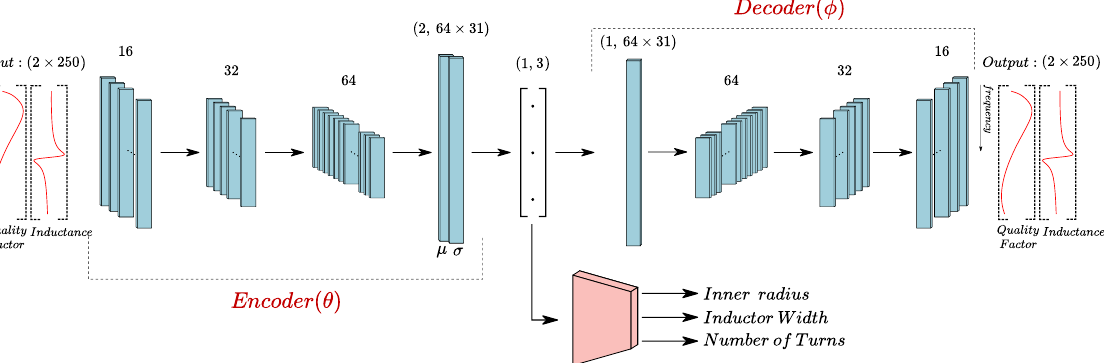
Figure 4. A depiction of the proposed composite model for spiral inductor representation learning. The 1D vectors of inductors’ Quality Factor and Inductance frequency behavior are inputs to the 1D convolutional filters of the architecture. The filter sizes are shown as well. The predictor FCNN obtains as an input the latent representation of the inductor’s frequency characteristics and yields its geometric